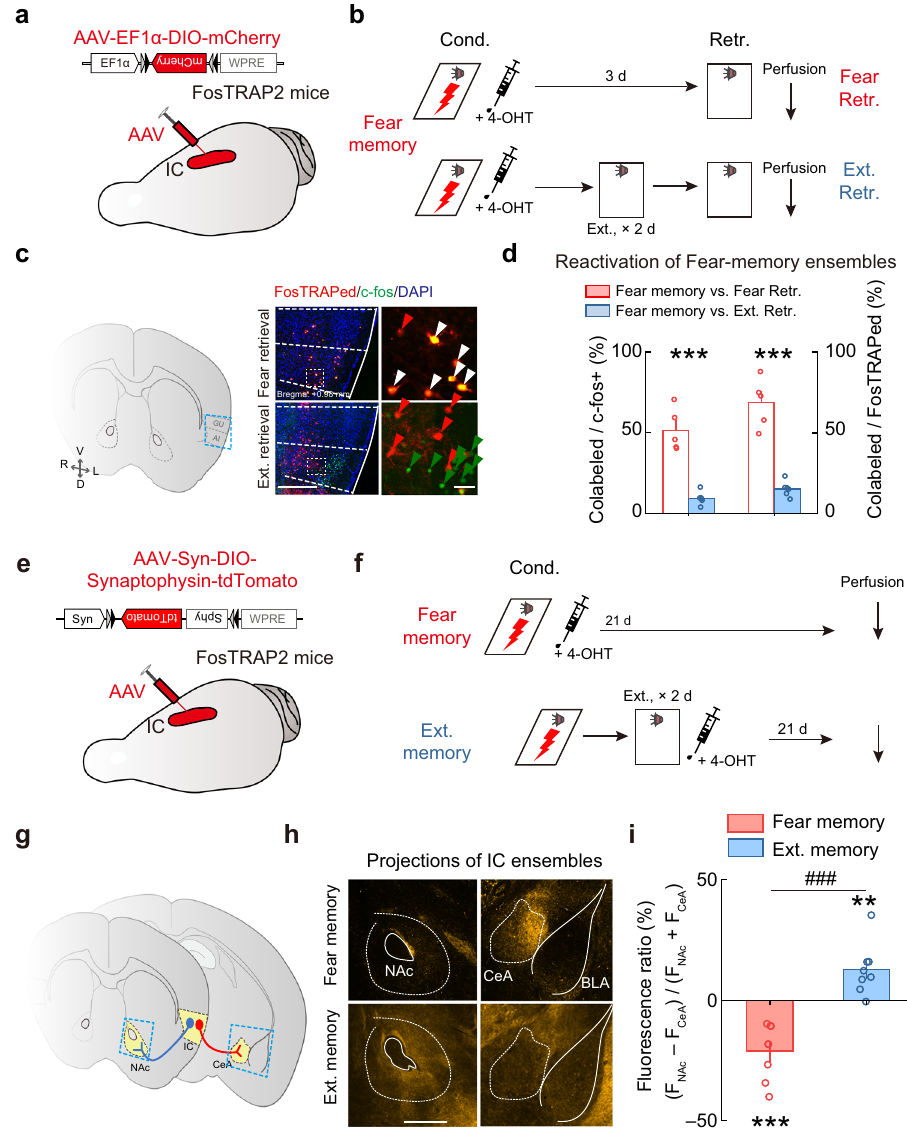
Fig. 3 | Fear and extinction memories activate distinct IC projection neurons. a – d Comparison between the distribution patterns of activated IC neurons during fear learning versus fear or extinction memory retrieval. a Schematic of AAV injection in IC. b Schematic of behavioral protocols. c Example images of Fos- TRAPed (red) and c-fos+(green) neurons in IC. Left: coronal diagram. Middle: enlargedviewoftheregioninthebluedashedboxshowingIC.Right:enlargedview oftheregioninthewhite-dashedboxinIC.Redarrowhead,FosTRAPedonly.Green arrowhead, c-fos+ only. White arrowhead, both FosTRAPed and c-fos+. Red, Fos- TRAPed; green, c-fos+; blue, DAPI. Scale bars, ( left ) 500 μ m, ( right ) 50 μ m. d OverlaprateofICneuronsactivatedduringfearlearningversusfearorextinction memoryretrieval.Theoverlaprateinthefearlearningversusfear-memoryretrieval group (red bar) was signi fi cantly higher than that in the fear learning versus extinction memory retrieval group (blue bar). Fear retrieval, n =5 mice. Ext. retrieval, n =6 mice. Colabeled/c-fos+: t (9) =7.508, *** P =3.6629E − 05; Colabeled/